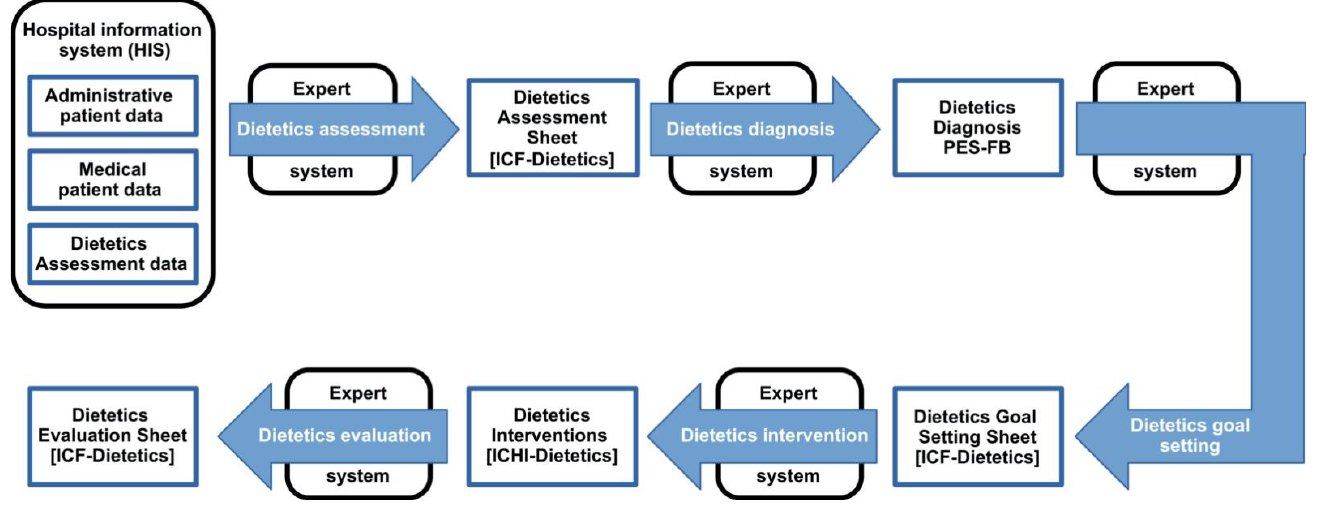
Figure 1. New DCP with document templates and standardized terminology (adapted from Krottenmüller [64] ).